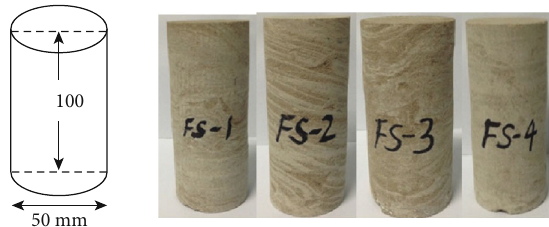
Figure 17: Pressure absorbent siltstone specimens.